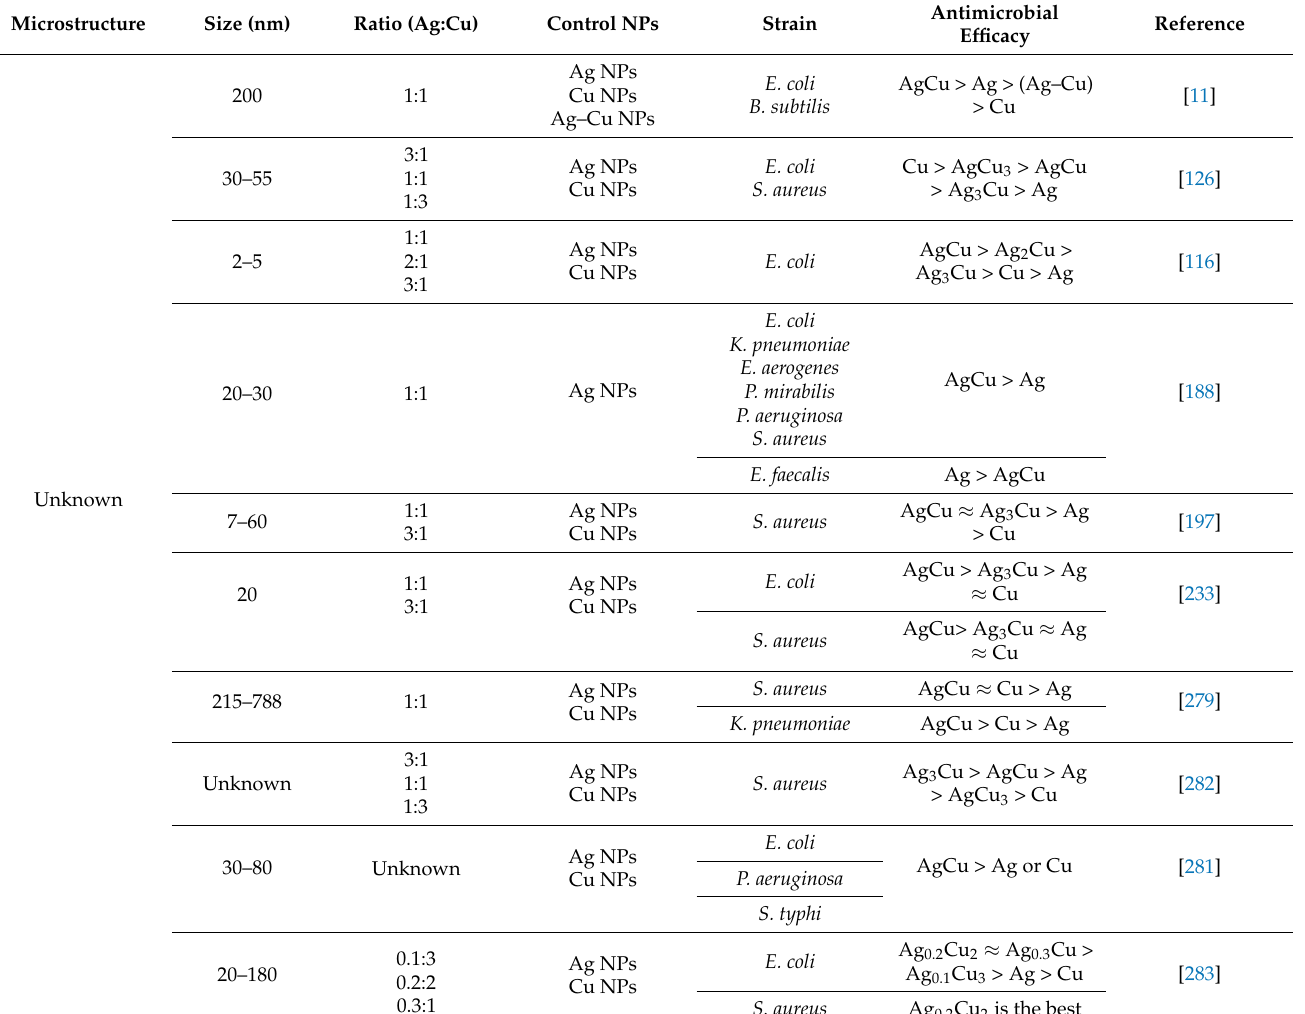
Table 2. Summary of microstructures and antimicrobial properties of Ag–Cu combinations.